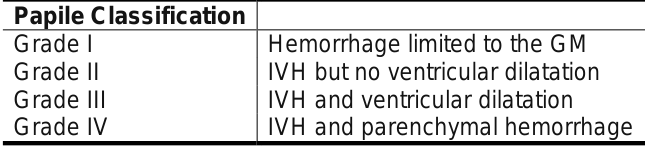
Table 1 . Papile's classification of preterm intraventricular